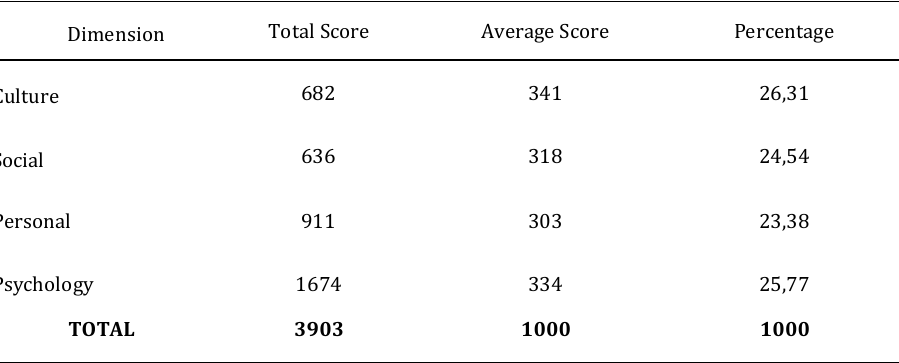
Table 2 Recapitulation of Tourist Responses on Millennial Tourist Decisions on Tourism Attractions in West